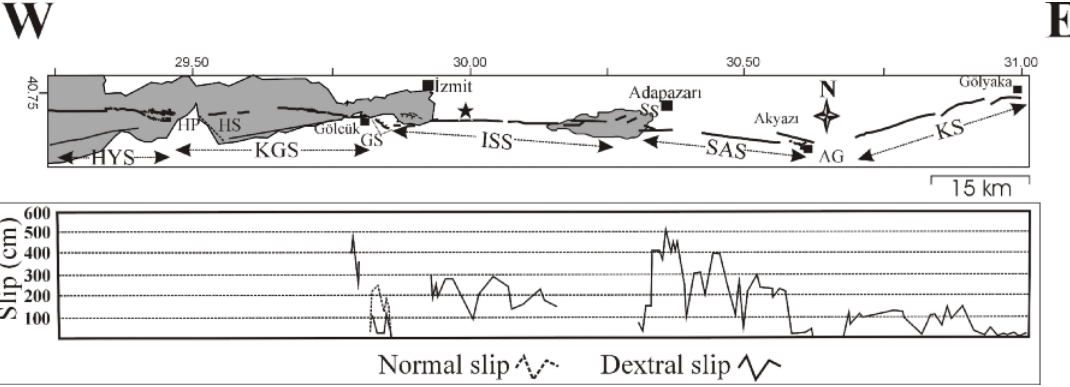
Figure 3. The surface ruptures of the 1999 İ zmit earthquake (thick black lines), as mapped from the field and submarine geology studies (above) and surface displacements measured along the surface ruptures (compiled from Barka et al. [2002], Lettis et al. [2002], Armijo et al. [2002], Cormier et al. [2006]). The earthquake was due to rupture of five fault segments, namely from east to west: the Karadere (KS), Sapanca-Akyazı (SAS), İ zmit-Sapanca ( İ SS), Karamürsel- Gölcük (KGS) and Hersek-Yalova (HYS) segments along the North Anatolian Fault Zone. Black star, epicentre of the 1999 İ zmit earthquake. AG, Akyazı Gap; SS, Sapanca stepover; GS, Gölcük stepover; HS, Hersek stepover; HP, Hersek